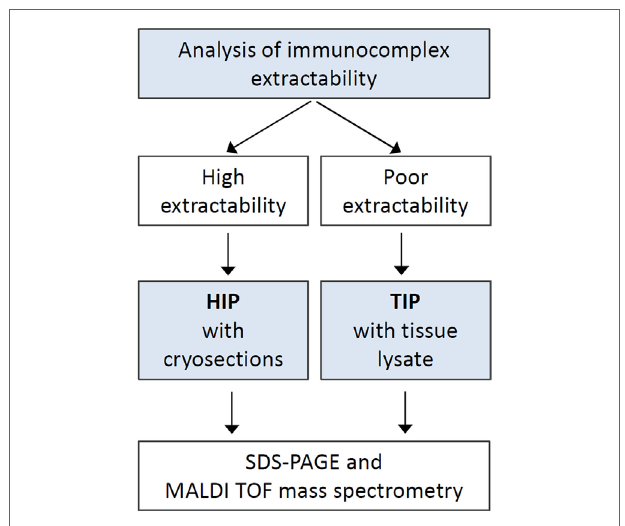
FigUre 1 | Procedure diagram. Schematic representation of the steps of antigen identification. Abbreviations: HIP, histo-immunoprecipitation; TIP,